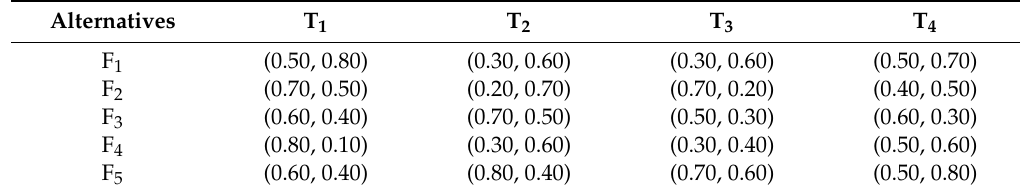
Table 7. Pythagorean fuzzy matrix by DM 2.